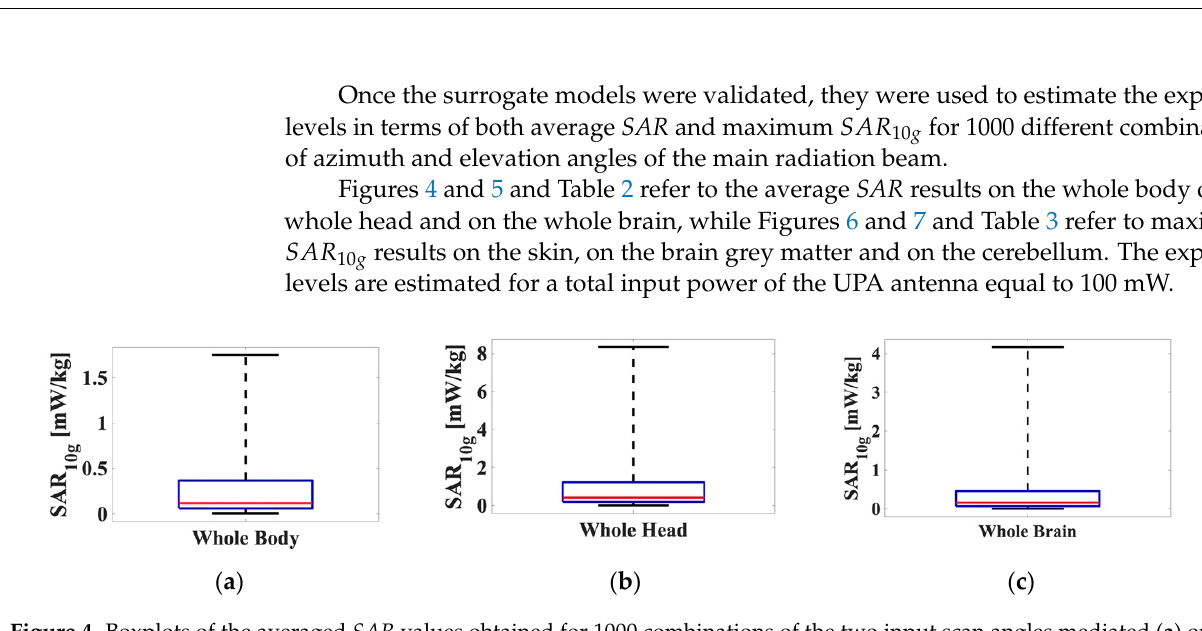
Figure 4. Boxplots of the averaged 𝑆𝐴𝑅 values obtained for 1000 combinations of the two input scan angles mediated ( a ) on the whole body, ( b ) on the whole head, and ( c ) on the whole brain. The lower and upper bound of the boxes represent the first and the third quartiles, the line is the median value, and the whiskers are the minimum and maximum values.